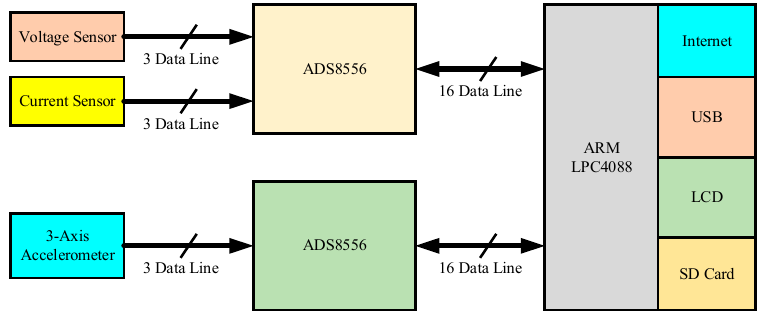
Figure 2. Front-end embedded system block diagram. Figure 2. Front ‐ end embedded system block diagram.